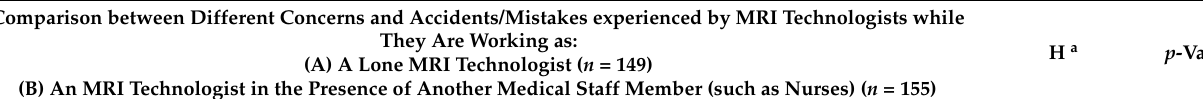
Table 5. Concerns and safety accident/mistake events experienced by MRI technologists.